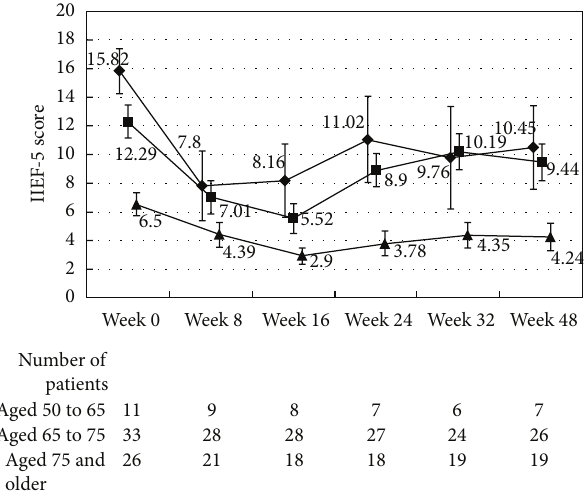
Figure 11: International Index of Erectile Function-5 score. The scores in the patients aged from 50 to 65 ( ⧫ ), the patients aged from 65 to 75 ( ◼ ), and the patients aged 75 and older ( 󳵳 ) are shown. The values are LS mean ± SE. 𝑃 = 0.0093 (repeated